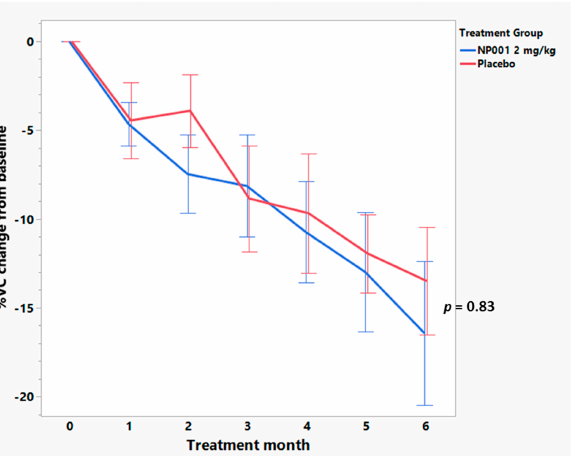
Figure 7. Comparison of vital capacity (VC) change from baseline over the six-month study in participants treated with NP001 compared to placebo in those aged ≤ 65 years old with low plasma CRP at baseline. %VC change from baseline for participants treated with NP001 ( n = 14) depicted in blue and compared to placebo group ( n = 13) depicted in red. Error bars represent the range, mean ± SEM (standard error of the mean) of %VC change from baseline. No differences were seen between NP001 and placebo groups by the end of study (NP001 = − 16.4% vs. Placebo = − 13.5%) (Wilcoxon test, p =